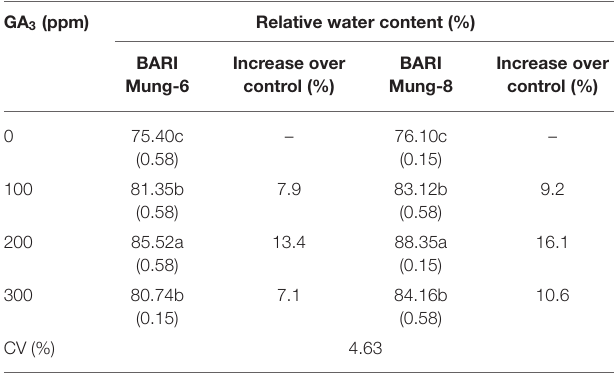
TABLE 3 | Effect of GA 3 on the relative water content (%) in the leaves of V. radiata